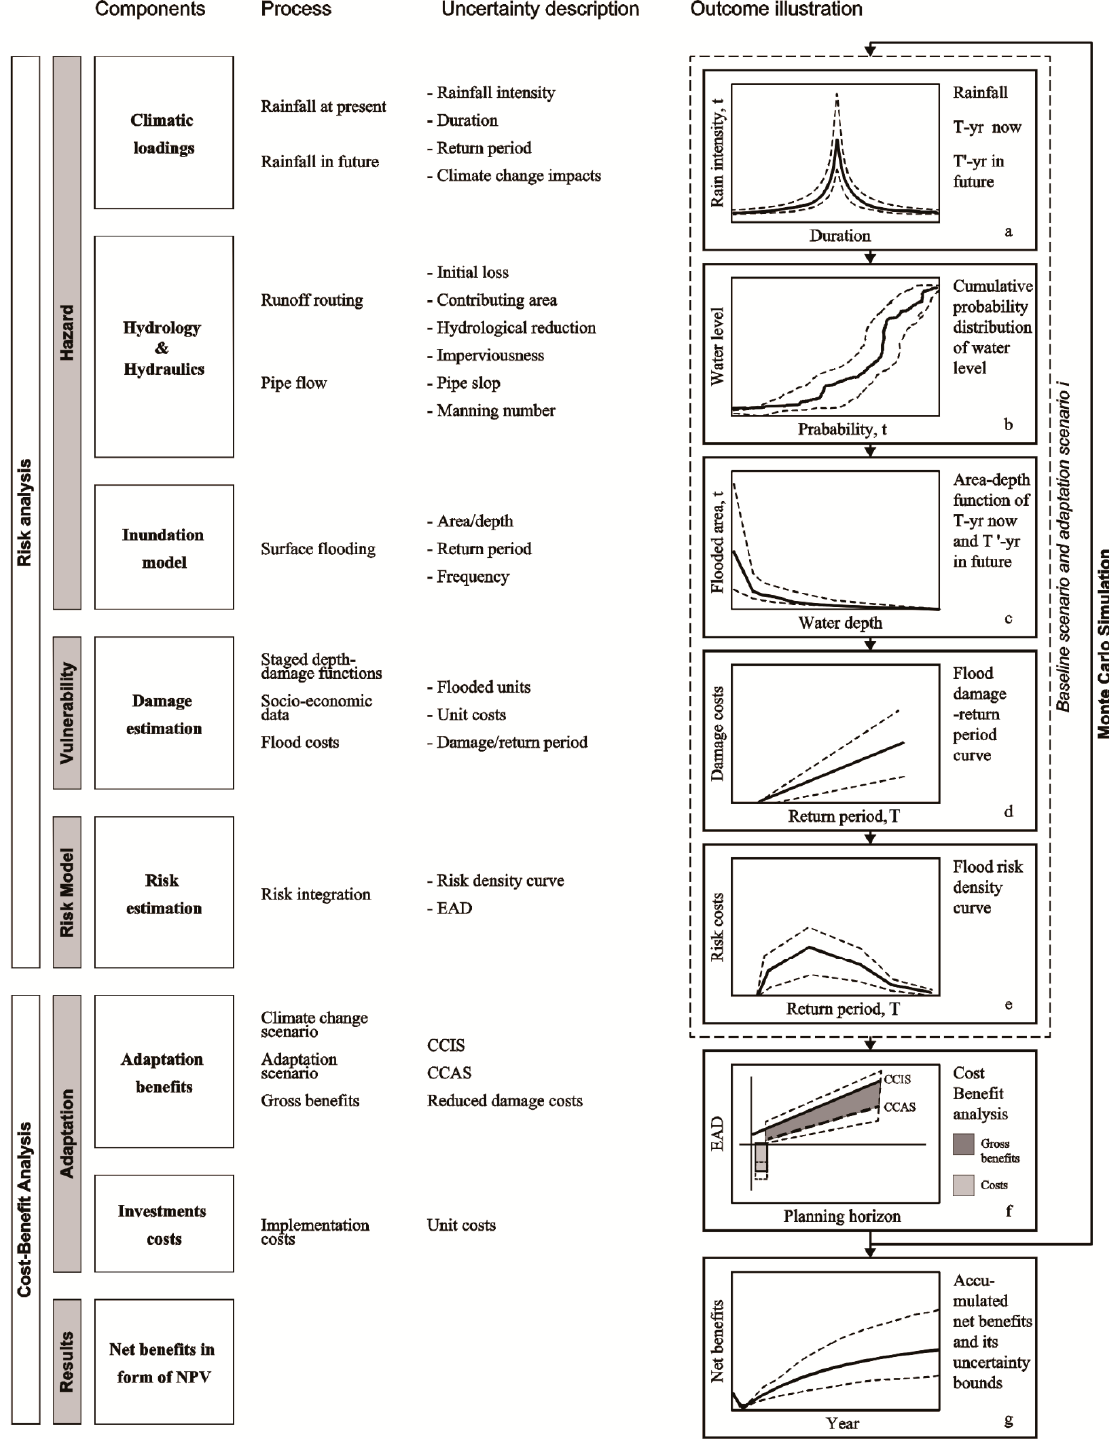
Figure 1. Visualization of the workflow of the proposed method. ( a – g ) illustrate the outcome of each of the steps of the workflow.